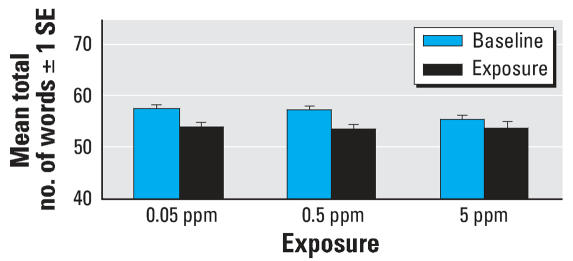
Mean total number of words recalled from List A over 5 trials on the AVLT. Change from baseline to during exposure: p < 0.0001.